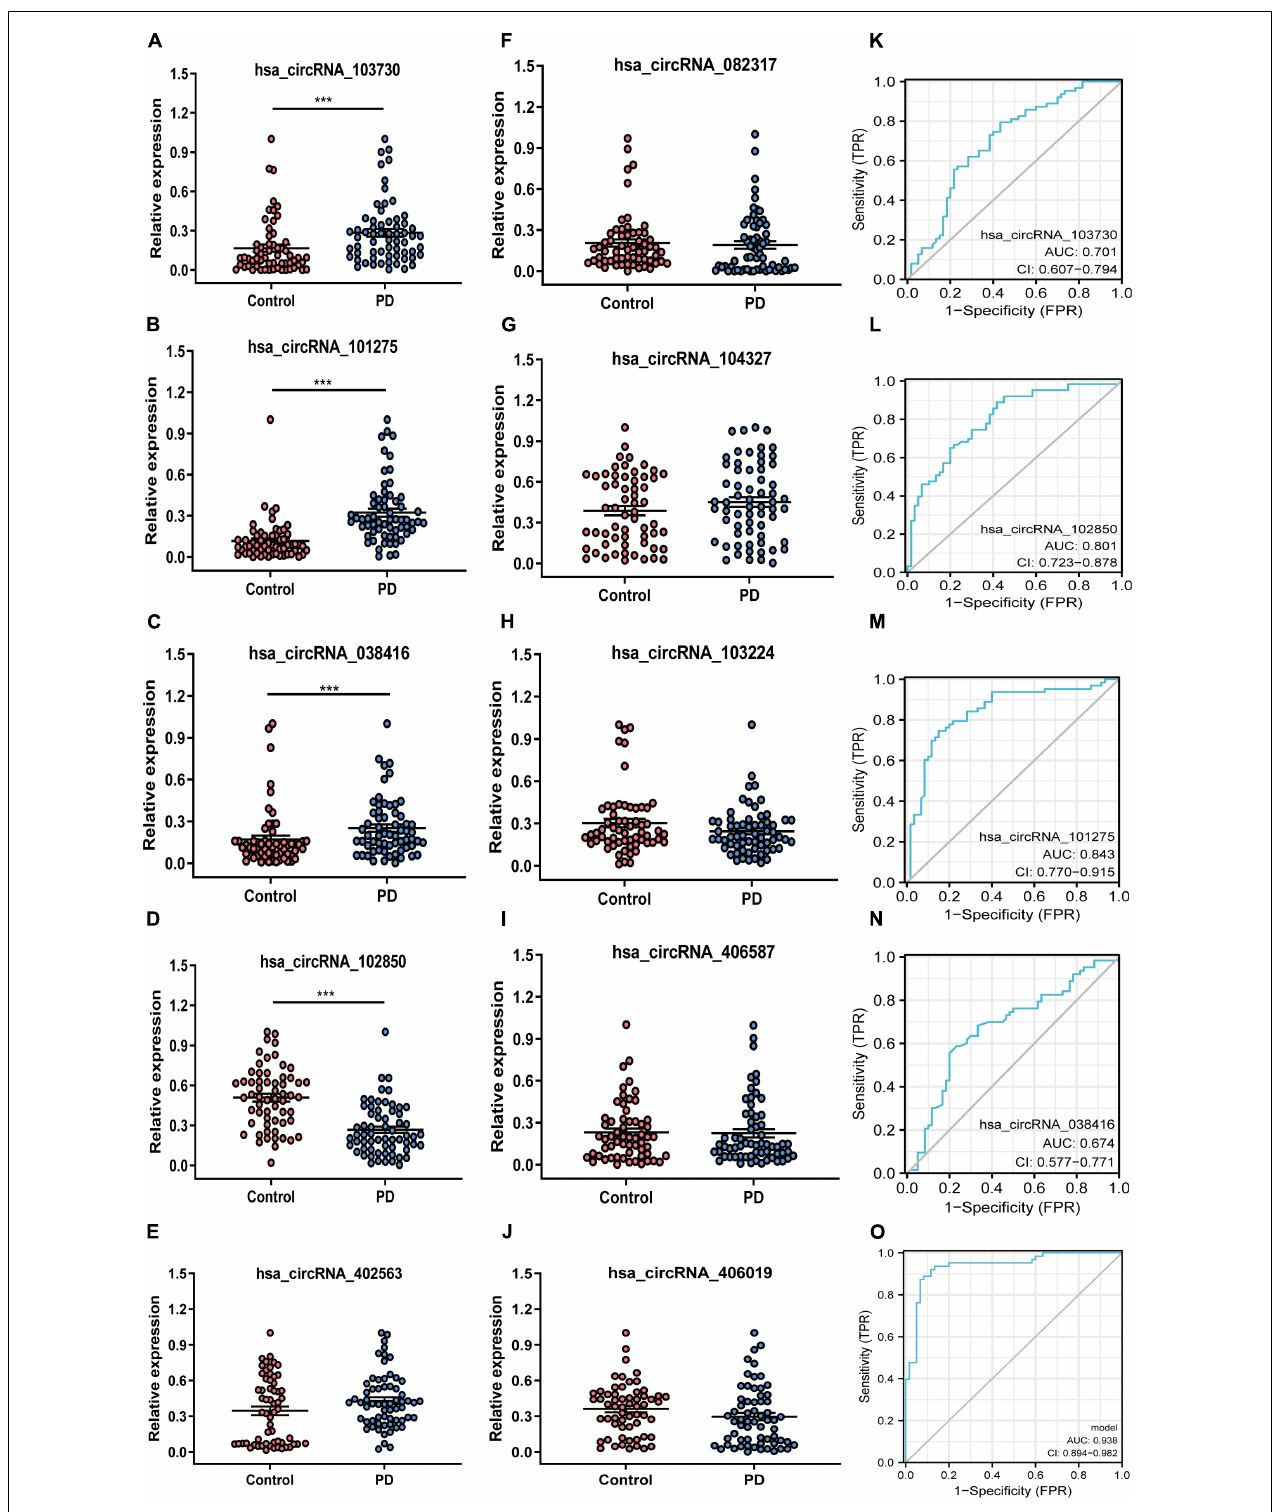
FIGURE 2 | Expression profile and ROC curves for circRNAs in patients with PD and healthy controls peripheral blood sample. (A–J) The relative expression level of ten candidate circRNAs in patients with PD and healthy control using RT-qPCR detection. (K–O) ROC analysis of the four differentially expressed circRNAs in peripheral blood samples. PD, Parkinson’s disease; control, healthy controls; circRNA, circular RNA; hsa, homo sapiens; AUC, the area under the curve; TPR, true positive rate; FPR, false-positive rate. *** p -value < 0.001.